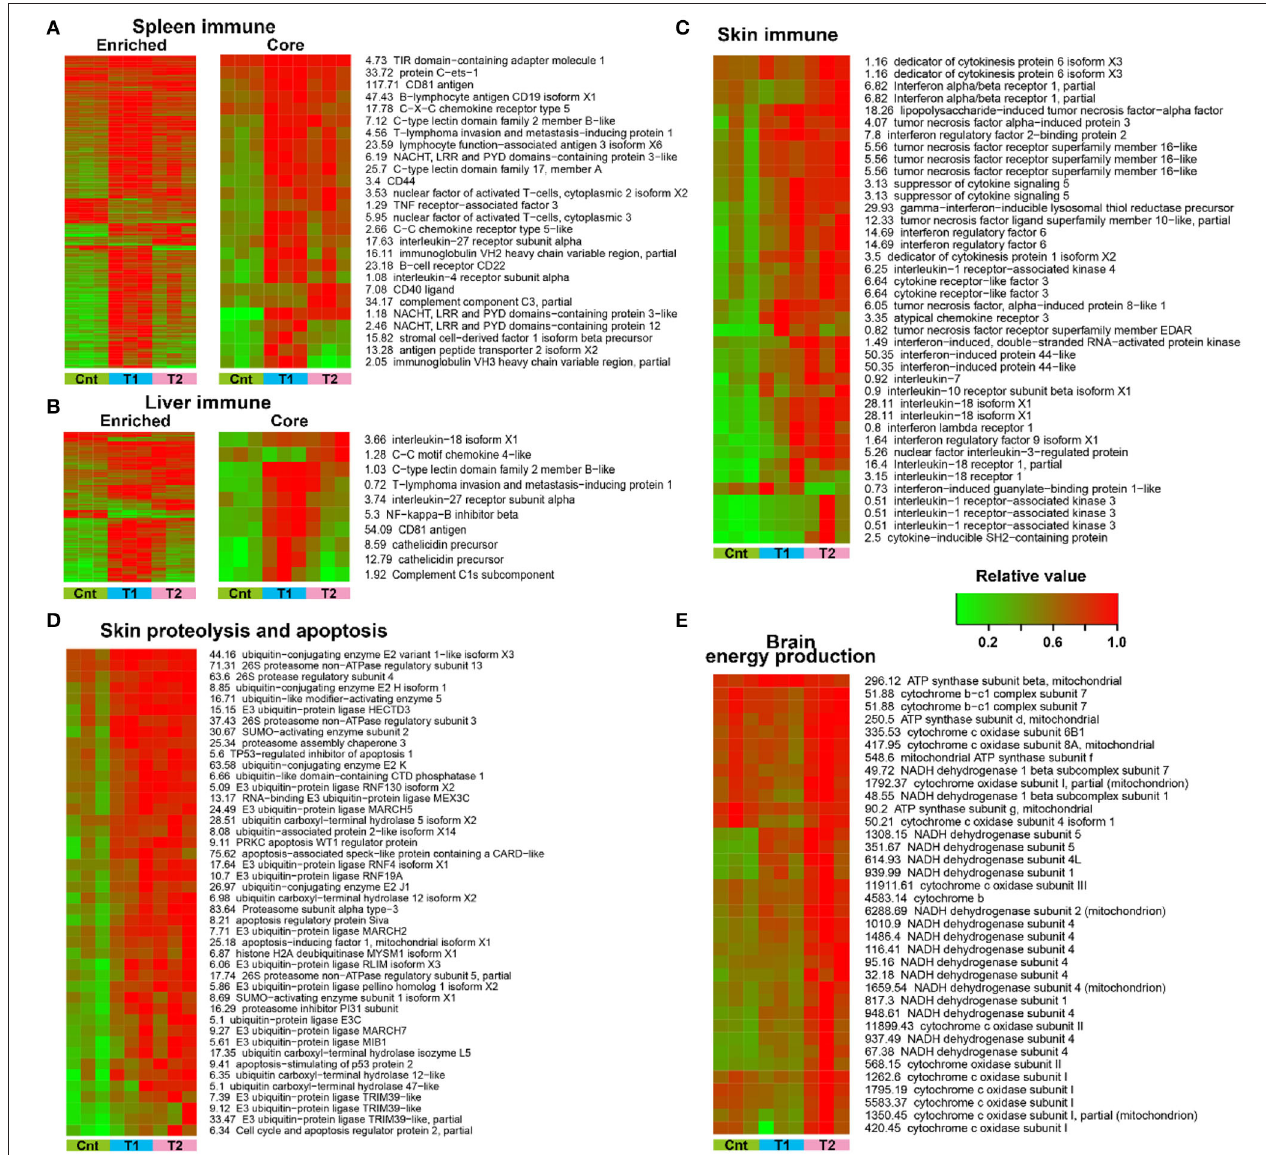
FIGURE 7 | Transcriptional variation trends of crucial and significantly enriched cellular processes. (A,B) Expression pattern of DEGs enriched in immune-related pathways in the spleen (A) and liver (B) . The core immune genes refer to those with defined immune functions. (C–E) Expression pattern of inflammation-related DEGs in the skin (C) , proteolysis and apoptosis-related DEGs in the skin (D) , and energy metabolic DEGs in the brain (E)